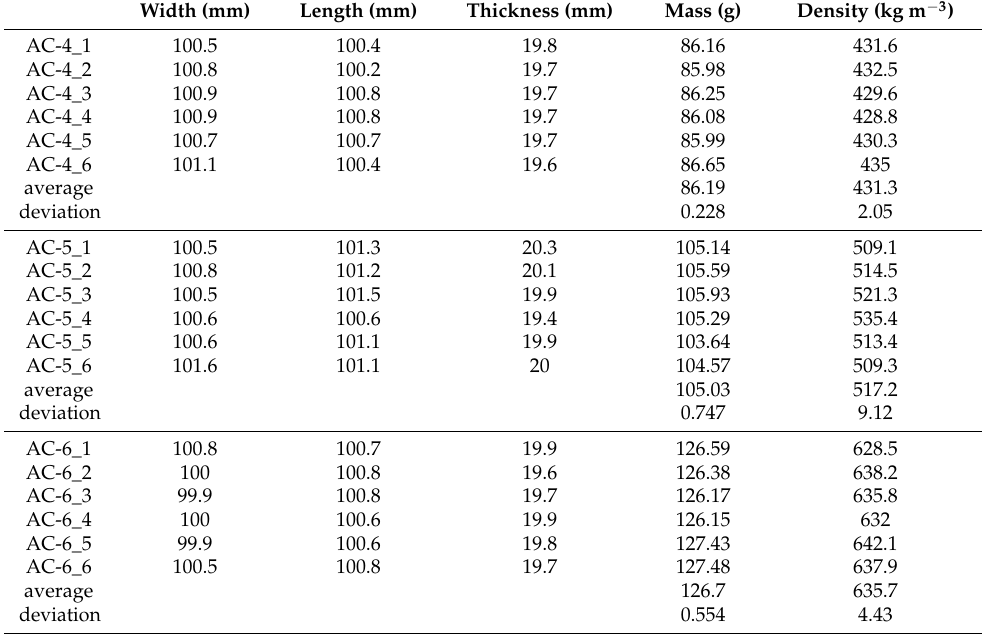
Table 5. The samples’ density measurements.